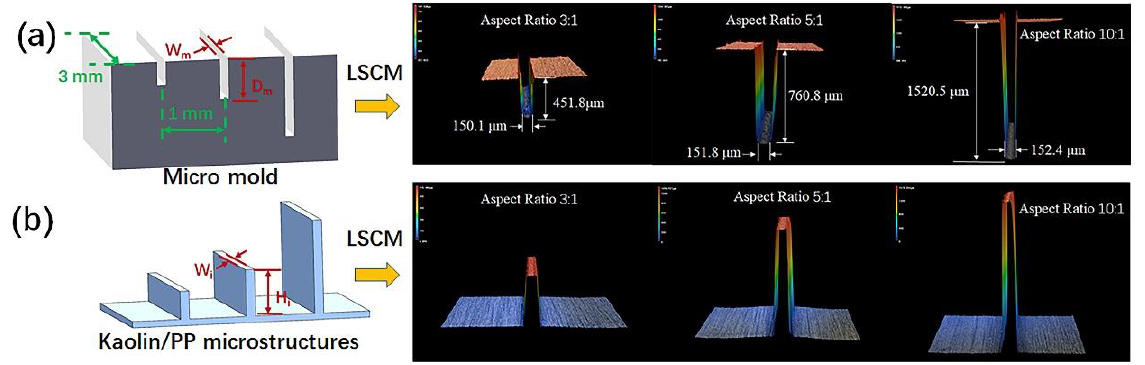
Figure 16. Cross-sectional dimensions of ( a ) microgrooves and ( b ) microstructured prismatic samples with aspect ratios of 3:1, 5:1, and 10:1.